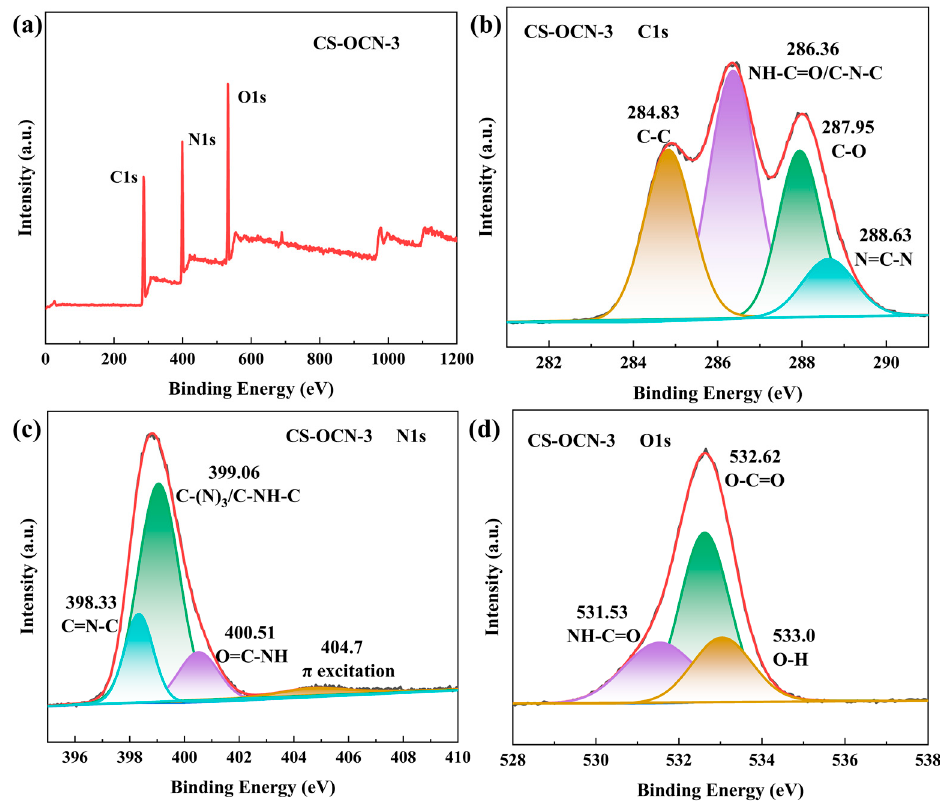
Figure 3. ( a ) XPS Survey, high-resolution ( b ) C 1s, ( c ) N 1s and ( d ) O 1s spectra of